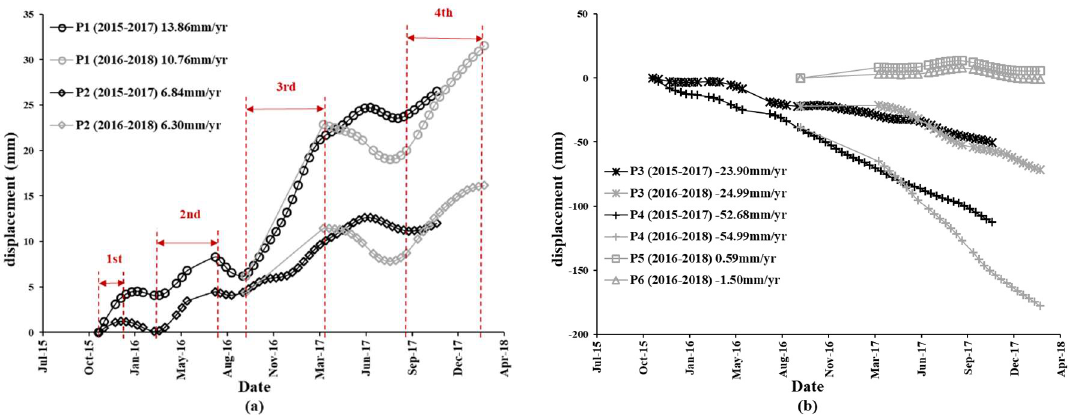
Figure 11. Temporal evolution of selected MPs. The location of the representative MPs are given in Figure 5. ( a ) P1 and P2 representing Zone A; and ( b ) P3 and P4 representing Zone B; P5 and P6 representing Zone C.